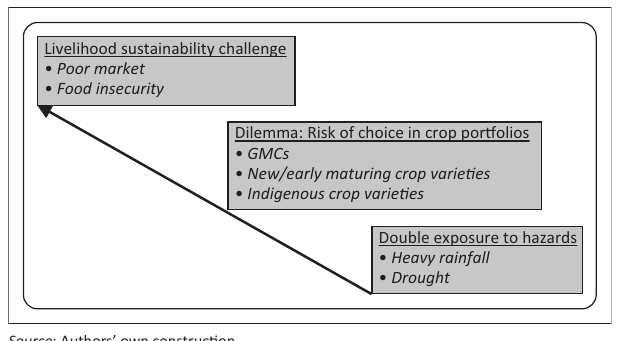
FIGURE 5: Ladder of agriculture vulnerability to climate